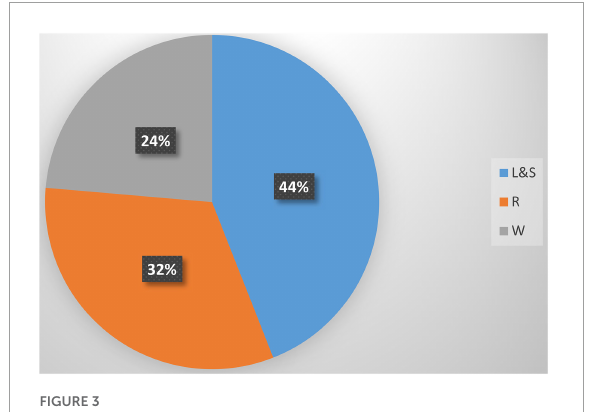
FIGURE3 Archival analysis of text interaction course